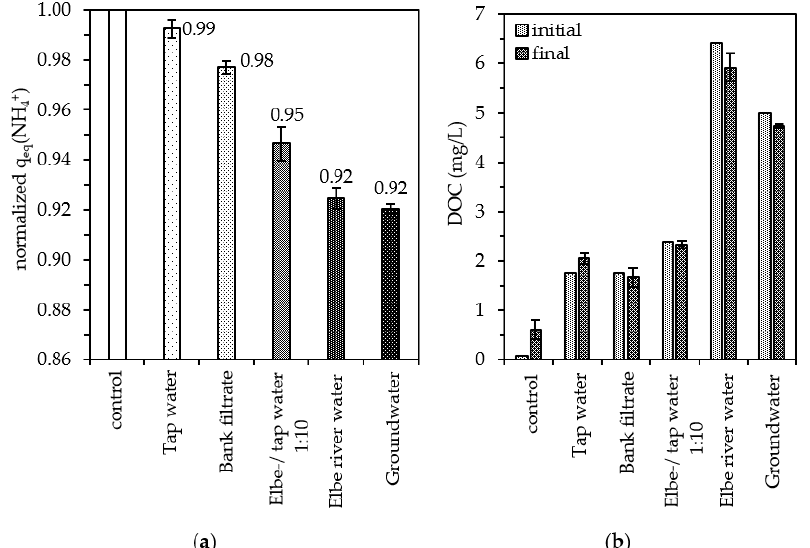
Figure 9. Influence of different natural water matrices on the normalized q eq (NH 4+ ) of a natural zeolite ( a ); initial and final DOC-concentrations after zeolite treatment ( b ) (matrix: natural; t eq : 14 d; pH control : 5.9; pH 0 : 7.8; c 0 (NH 4+ ) = 0.71 mmol/L; w / v = 100 g Z /L; T = 22 °C; grain size: 8–16 mm; n = 3).